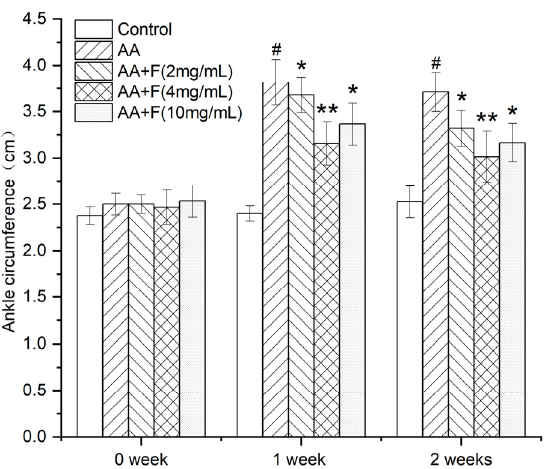
Figure 1. Effects of different treatments on reducing ankle joint circumference of arthritic rats (x ± SD). Error bars represent standard deviations ( n = 6). As compared with control group, # p < 0.05 indicates the arthritis model was established successfully. As compared with the AA group, * p < 0.05 indicates significant effects of AA+F (2 mg/mL) and AA+F (10 mg/mL) treatments in alleviating ankle joint swelling in arthritic rats; ** p < 0.01 indicates a more significant effect of AA+F (4 mg/mL) in reducing ankle joint circumference of arthritic rats.